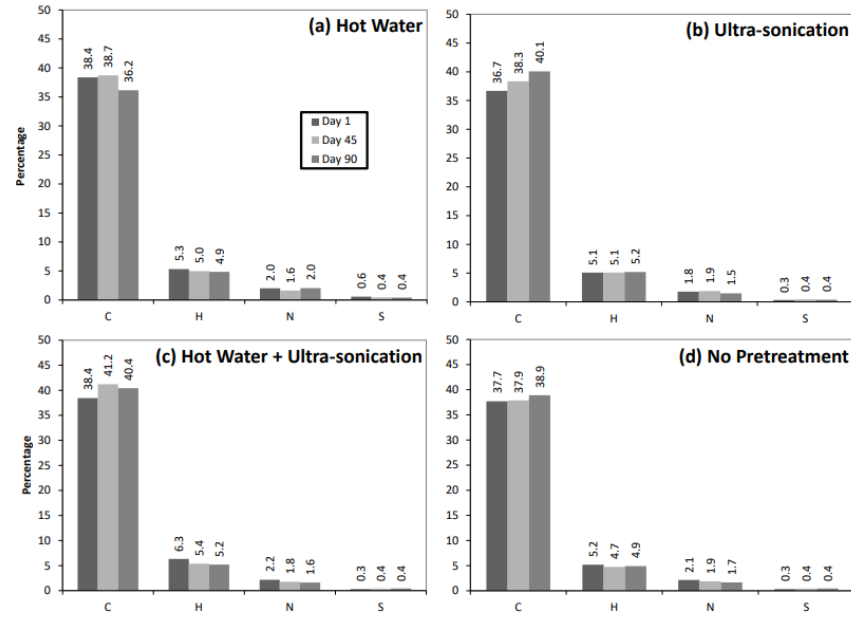
Figure 5. Ultimate substrate analysis during the digestion process of cotton gin trash.